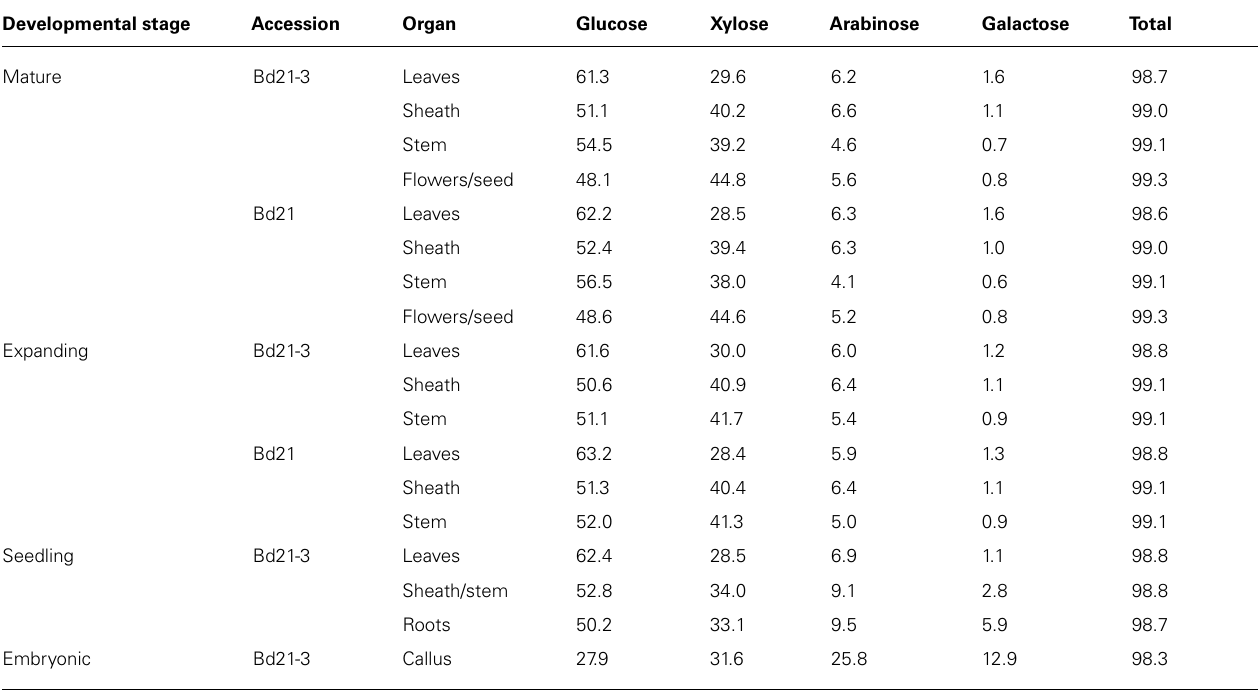
Table 4 | Major neutral sugar mole percentage in Brachypodium cell walls*.